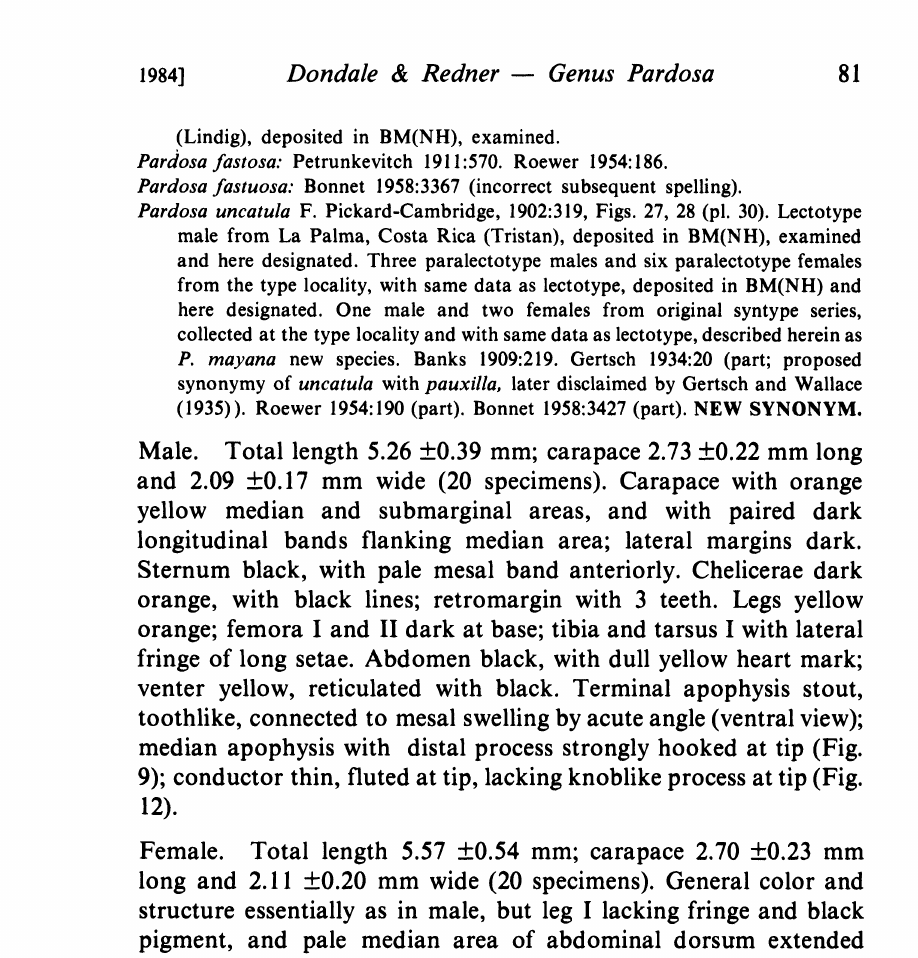
(Lindig), deposited in BM(NH), examined. Pardosafastosa: Petrunkevitch 1911:570. Roewer